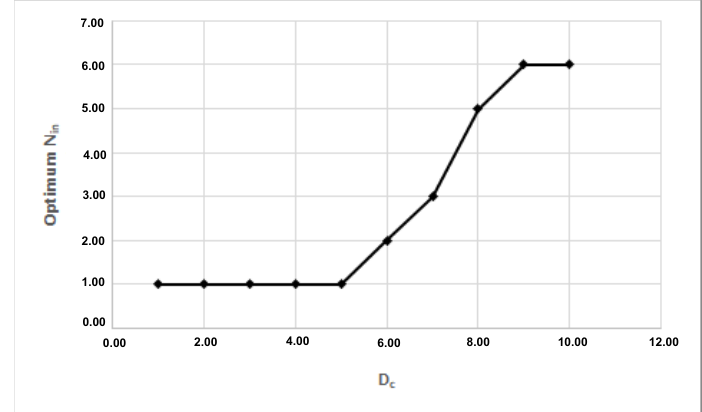
Figure 25. Variations of optimum N in per D c .